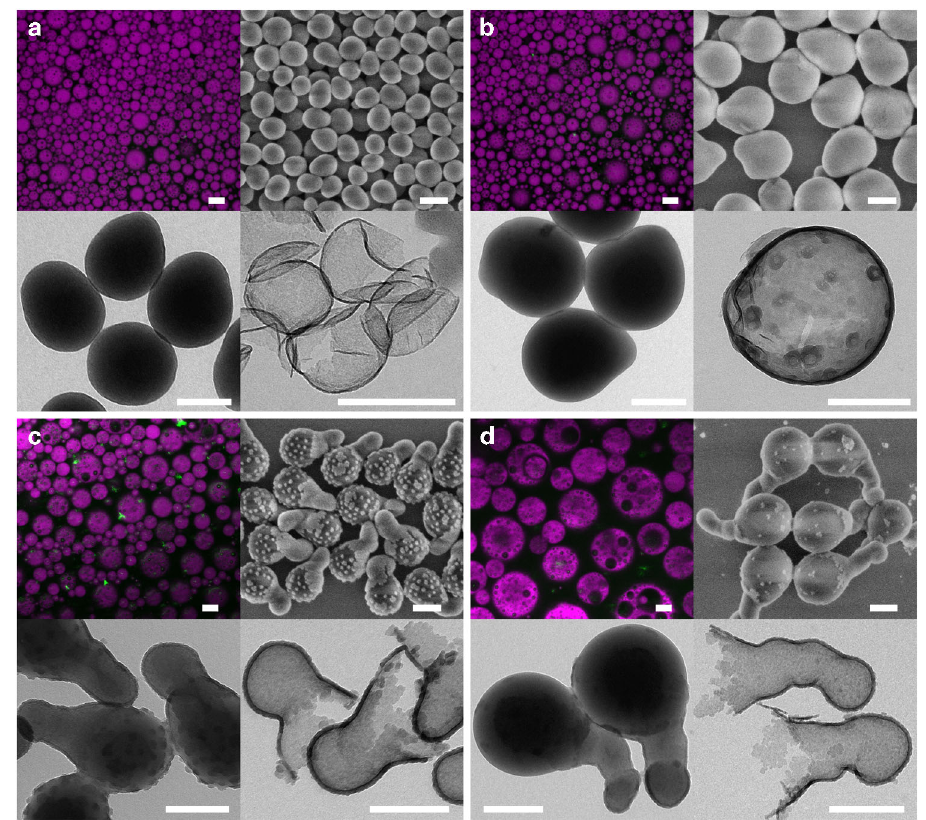
Fig. 4 Conversion of microsized multiple emulsions. The mass ratio of PEOS to styrene is 1:1, the inner water phase to the oil phase is 1:10, and the primary W/O emulsion to the outer water phase is 1:10. The pH value of the water phase is 7. Multiple emulsions are prepared using a rotor-stator homogenizer running at different rotation speeds: a – d 18,000, 12,000, 9000, and 4000 r.p.m. For each speed, a fl uorescence micrograph (scale bars = 10 μ m) of the emulsion (upper left), a FESEM image (upper right, scale bars = 200 nm), and TEM images of particles before (lower left, scale bars = 200 nm) and after calcination (lower right, scale bars = 200 nm) are